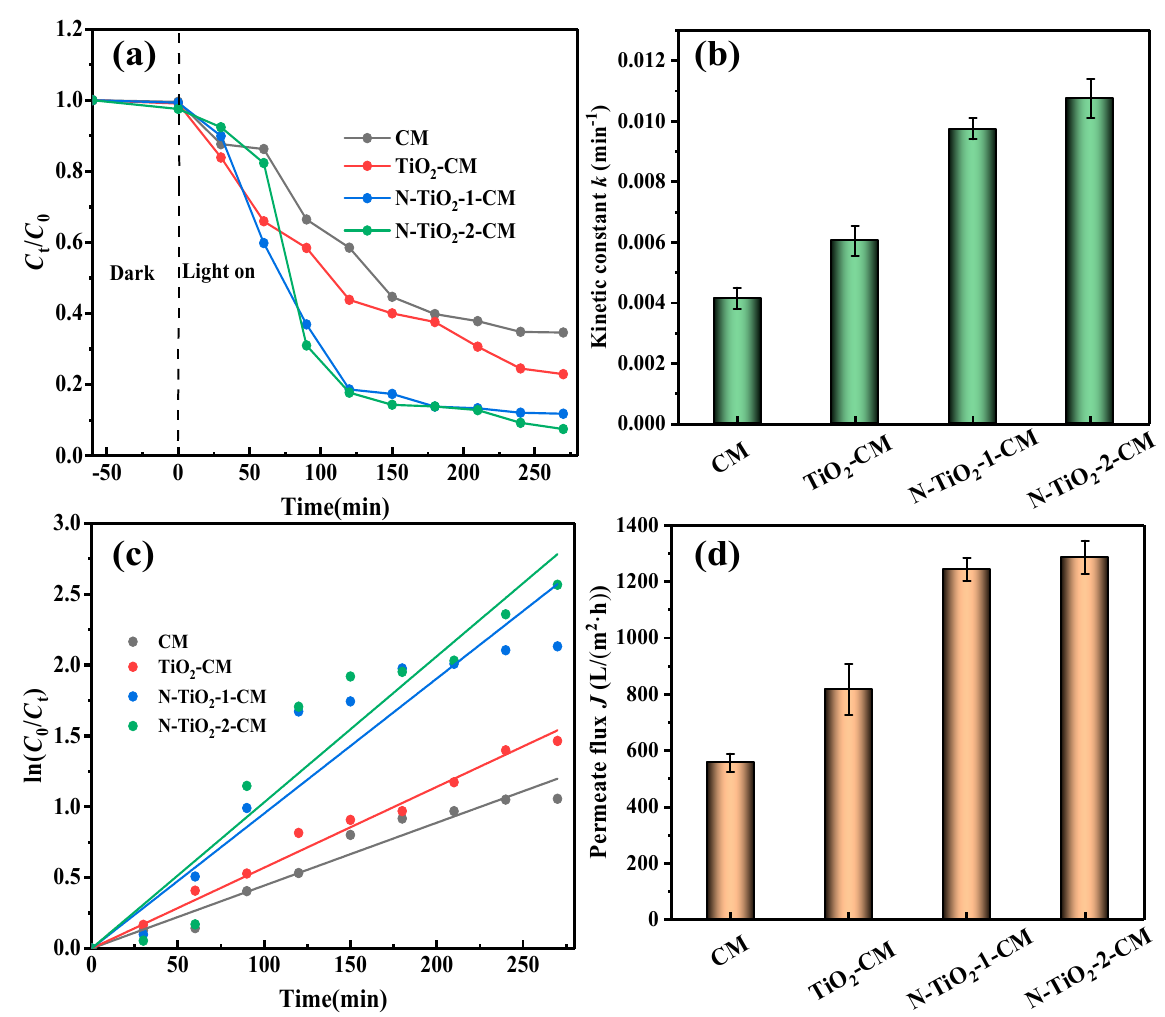
Figure 7. The removal efficiency ( a ); permeate flux ( b ); degradation kinetics ( c ); and kinetic constant k ( d ) of the TC degradation in the PRCM fixed bed system. (Reaction conditions: C 0 = 20 mg/L, reaction volume = 2 L, LED UV lamp (2 × 405 nm) with an intensity 24 µ mol/(m 2 × s), PRCM loading layers = 3).